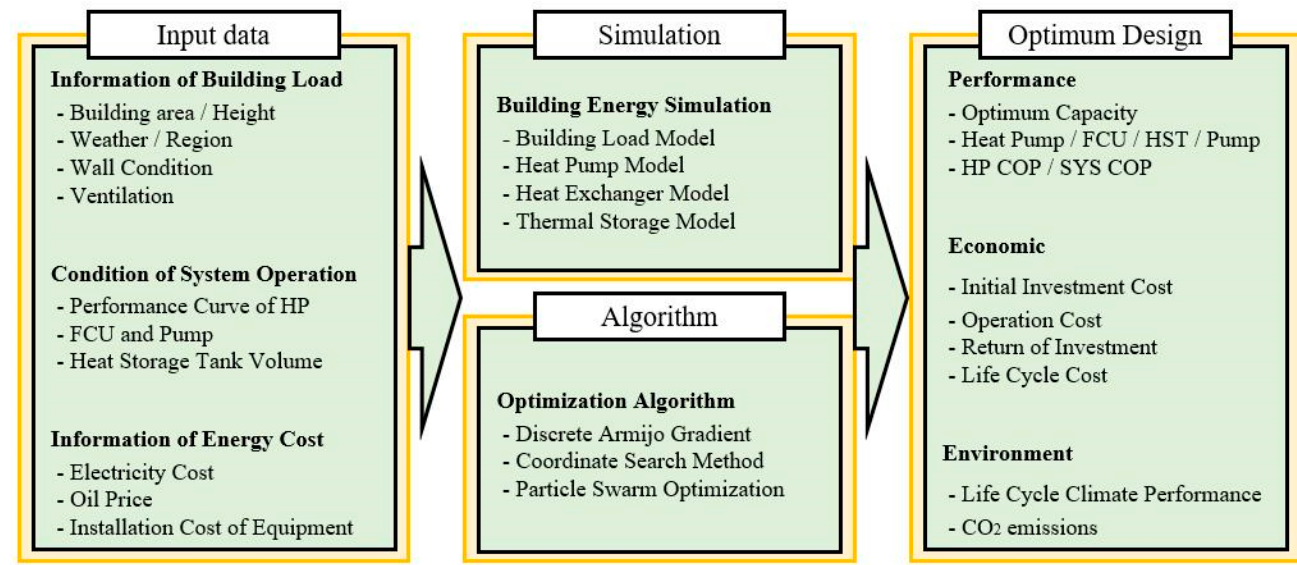
Figure 2. Proposed optimum design method.